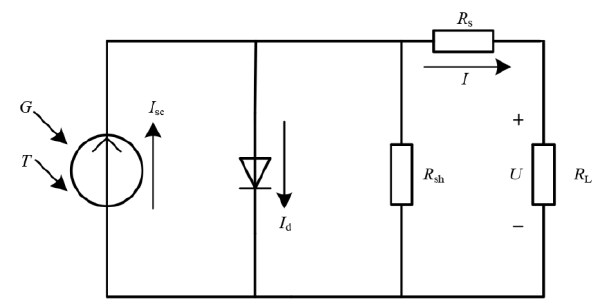
Figure 1. Equivalent model of the photovoltaic (PV) cell.